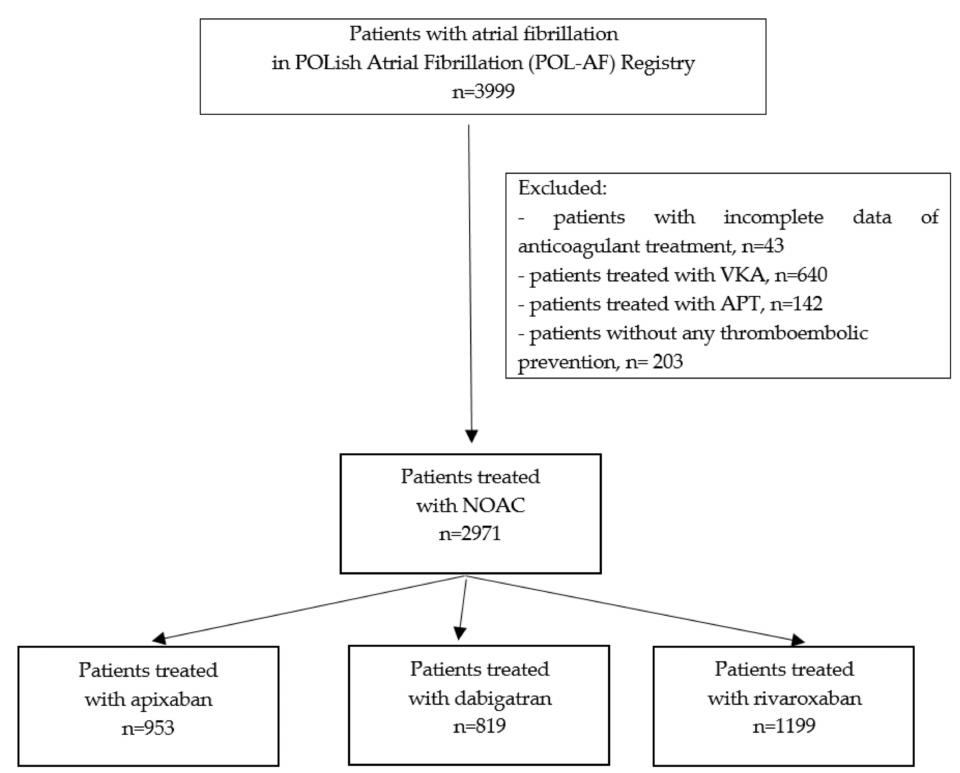
Figure 1. The flow chart of the study. Abbreviations: APT, antiplatelet drug; NOAC, non-vitamin K antagonist oral anticoagulant; VKA, vitamin K